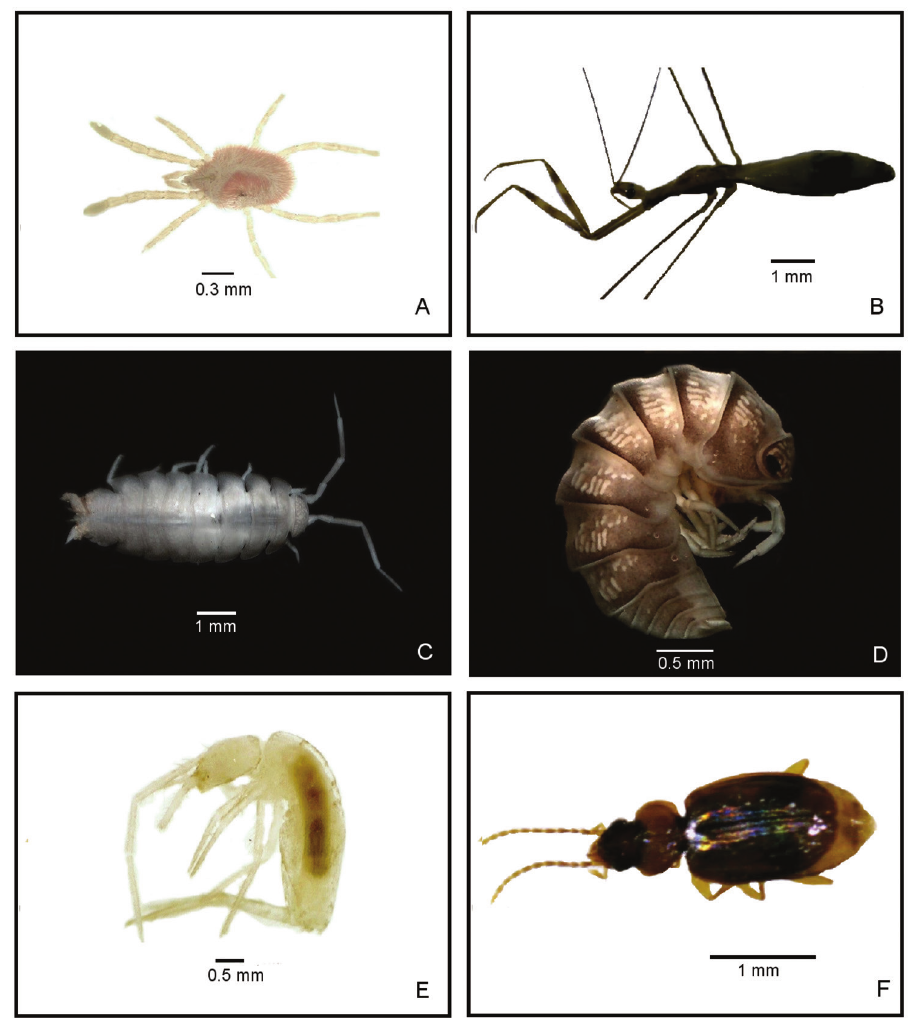
Figure 4. Fauna from caves of northeastern Goiás, central Brazil: A Mesostigmata (Acari) B Emesinae (Hemiptera: Reduviidae) C Venezillo congener (Isopoda: Armadillidae) D Dubioniscidae (Isopoda) E Tro- golaphysa (Collembola: Paronellidae) F Paratachys sp. (Coleoptera: